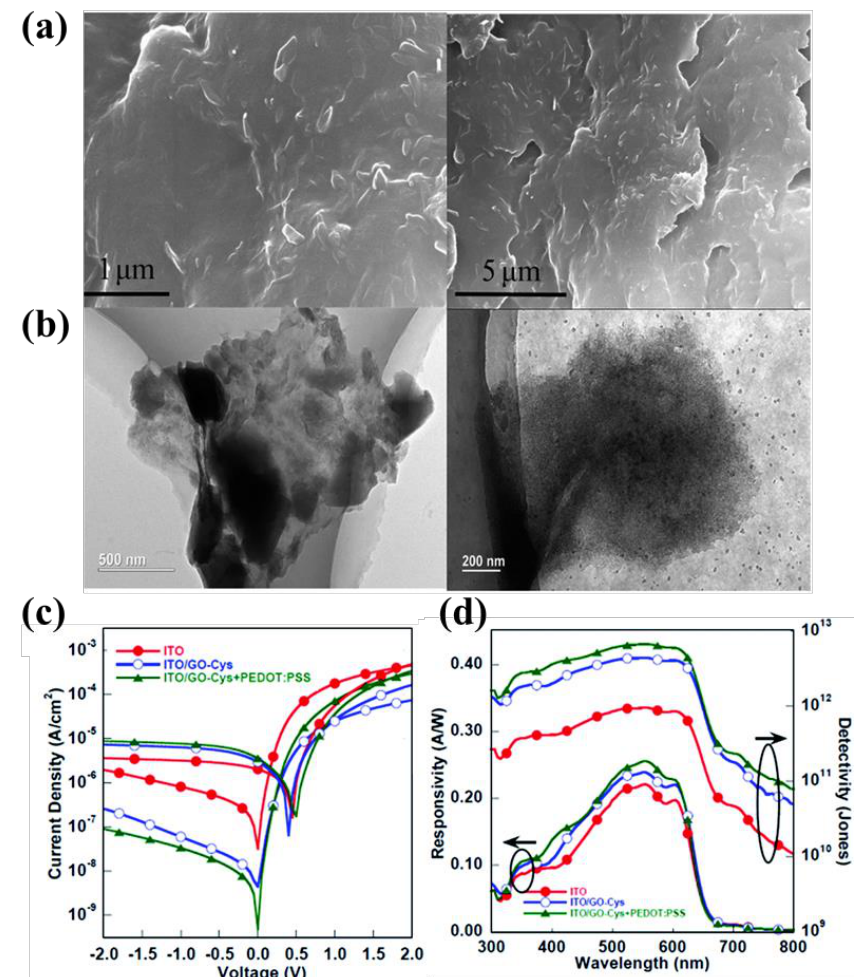
Figure 15. ( a ) SEM image films fabricated with the blend of PEDOT:PSS and GO–Cys; ( b ) TEM images of GO–Cys/PEDOT:PSS composites; ( c ) Current–density to voltage (J–V) characteristics of OPDs with ITO, ITO/GO–Cys or ITO/GO–Cys + PEDOT:PSS as the cathode; ( d ) Responsivity and D* under −0.1 V versus the wavelength of the OPDs. (Reproduced with permission from [130]. The Royal Society of Chemistry Publishing, 2014).